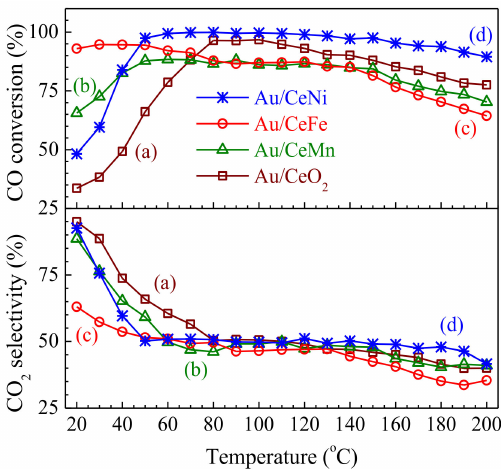
Figure 11. Light-off profiles (temperature-programmed reaction) of CO PROX in H 2 -rich stream over CeO 2 and doped CeM supported gold catalysts: ( a ) Au/CeO 2 ; ( b ) Au/CeMn; ( c ) Au/CeFe; ( d ) Au/CeNi.